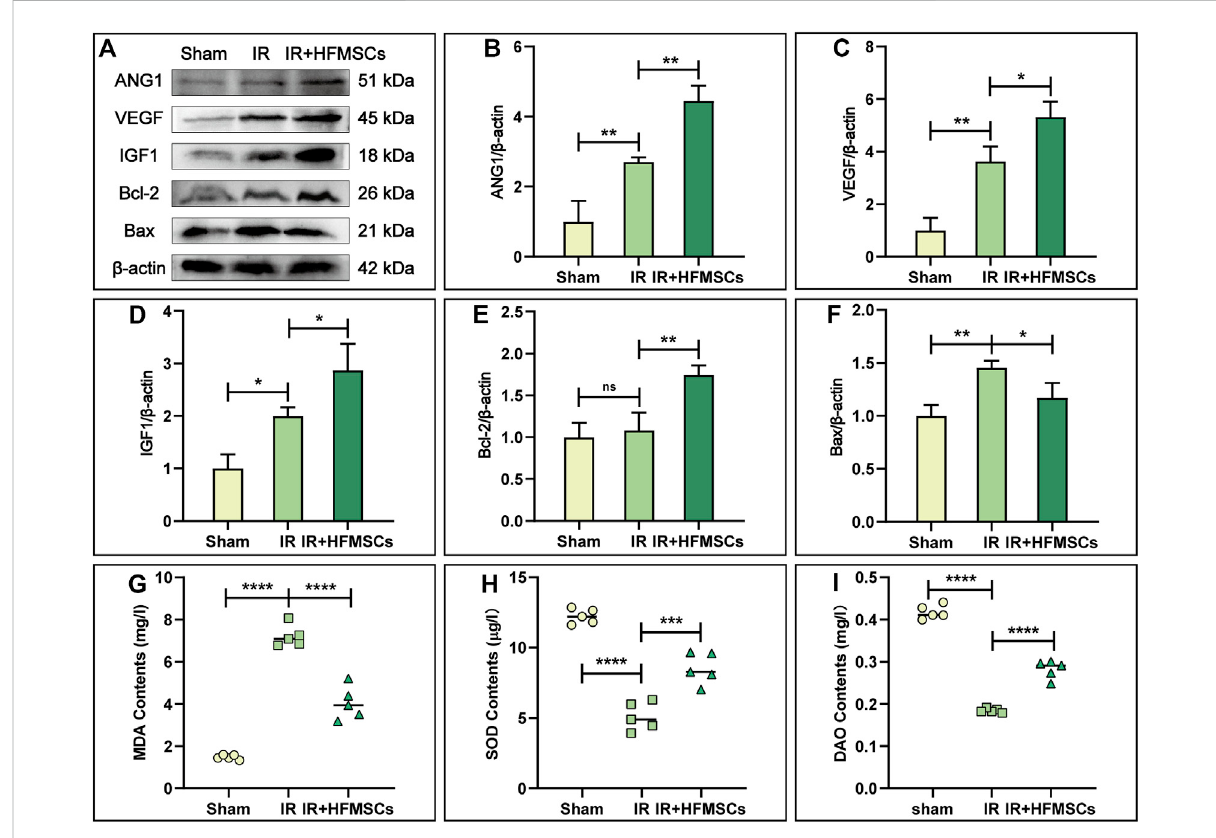
FIGURE 6 HFMSCs promoted angiogenesis, inhibited apoptosis, regulated oxidative stress and improved intestinal barrier function. (A) Representative Western blot images of ANG1, VEGF, IGF1, Bcl-2, and Bax in small intestinal tissues from different groups ( n = 3). β -actin served as a reference. (B – F) Statistical analysis showed that ANG1 (B) , VEGF (C) , IGF1 (D) and Bcl-2 (E) expression levels were the highest in the IR + HFMSCs group, and Bax expression levels were lower in the IR + HFMSCs group than in the IR group (F) . (G – I) Statistical analysis of the MDA (G) , SOD (H) and DAO (I) levels in the small intestine in different groups ( n = 5), as analysed by ELISA. The IR + HFMSCs group expressed less MDA than the IR group, whereas the IR + HFMSCs group expressed higher levels of SOD and DAO. Data are presented as the mean ± SD (* p < 0.05, ** p < 0.01, *** p < 0.001, **** p < 0.0001, ns indicates no signi fi